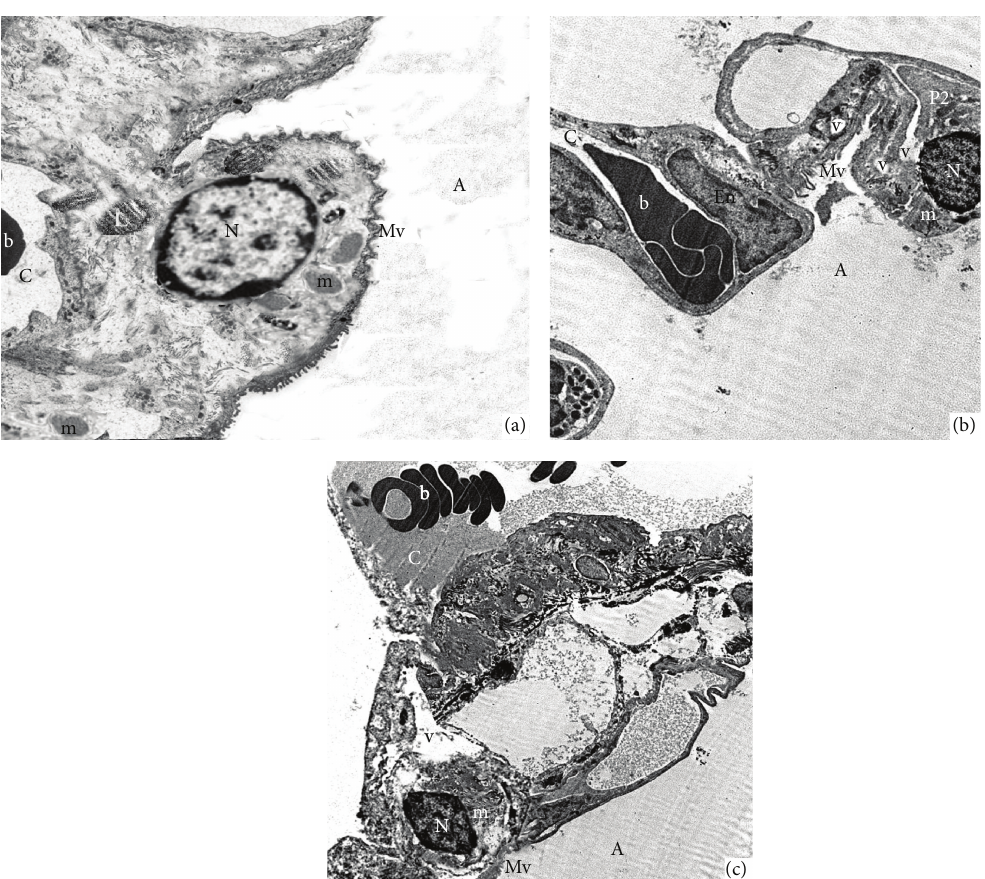
Figure 5: (a) Electronic microscopic picture of the control rat lung shows rounded nucleus (N) of pneumocyte type II, lamellar bodies (L) aroundthenucleus,andmitochondria(m)incytoplasmwithmicrovilli(Mv)onthesurfaceofalveoli(A)( × 10000).(b)Electronicmicroscopic picture of the second group rat lung shows a shrinkage nucleus (N) of pneumocyte type II, vacuoles and congested blood capillaries (C) filled with the blood (b) in the cytoplasm and around the nucleus, degenerated mitochondria (m) in cytoplasm with degenerated microvilli (Mv) on the surface of alveoli (A) ( × 10000). (c) Electronic microscopic picture of the third group rat lung shows pyknotic nucleus (N) of pneumocyte type II, a variable number of vacuoles (v) and more congested blood capillaries (C) filled with the blood (b) around the nucleus, and degenerated mitochondria (m) in cytoplasm with degenerated microvilli (Mv) on the surface of alveoli (A) ( ×